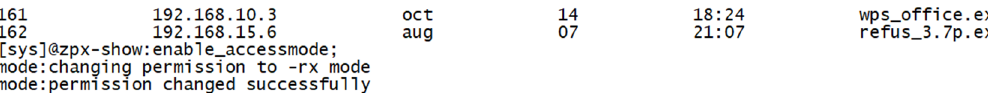
Figure 11. Change the mode of files.